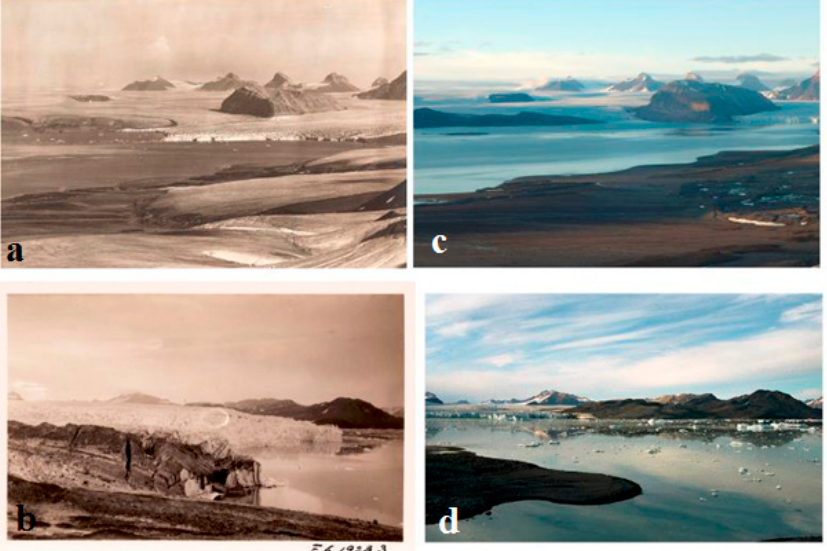
Figure 3. The glacier front in Svalbard has retreated significantly in the past 80 years. ( a , b ) Glacier front 80 years ago ( c , d ). The present glacier front. Source: (https://im- age.so.com/i?src=360pic_strong&z=1&i=0&cmg=154; 25 February 2018).